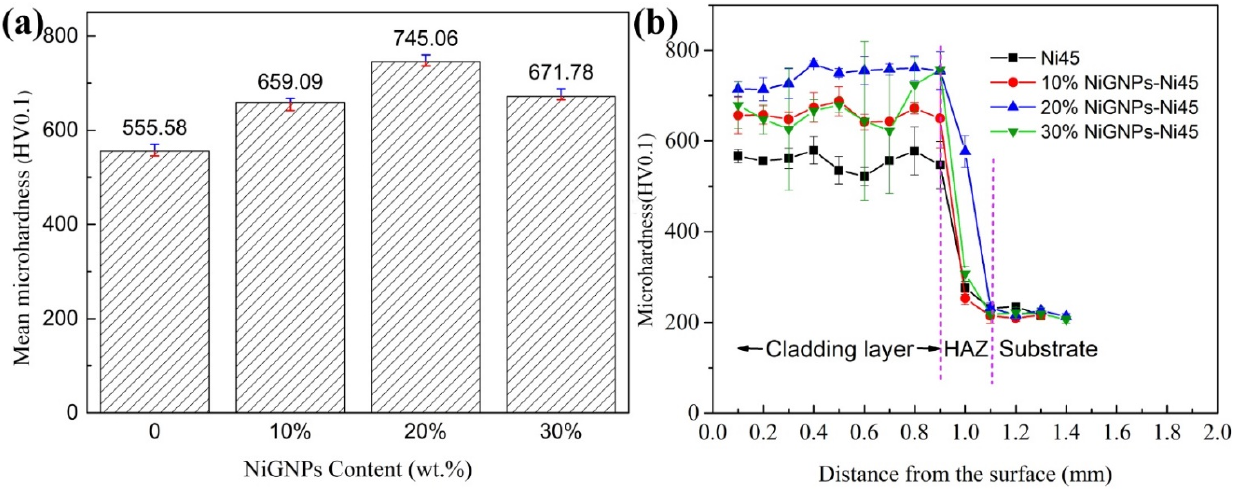
Figure 7. ( a ) Mean microhardness and ( b ) cross-sectional microhardness distribution of Ni-based composite coatings with different GNPs content.